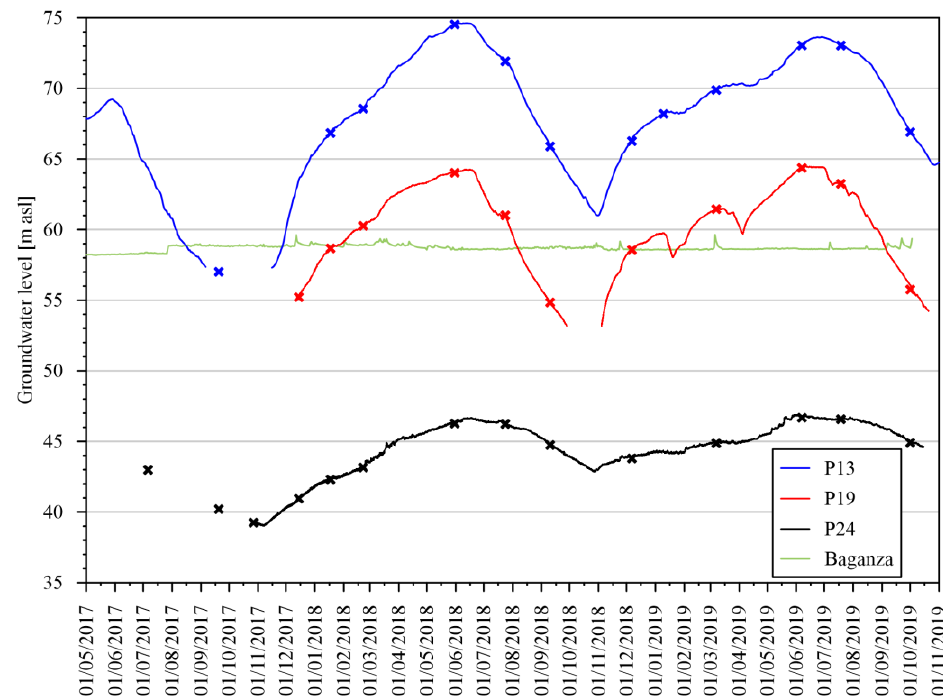
Figure 6. Groundwater level observed at three monitoring wells through automatic probes and hydraulic level observed at the river station of Baganza River (see Figure 3). The crosses indicate the manual measurements.